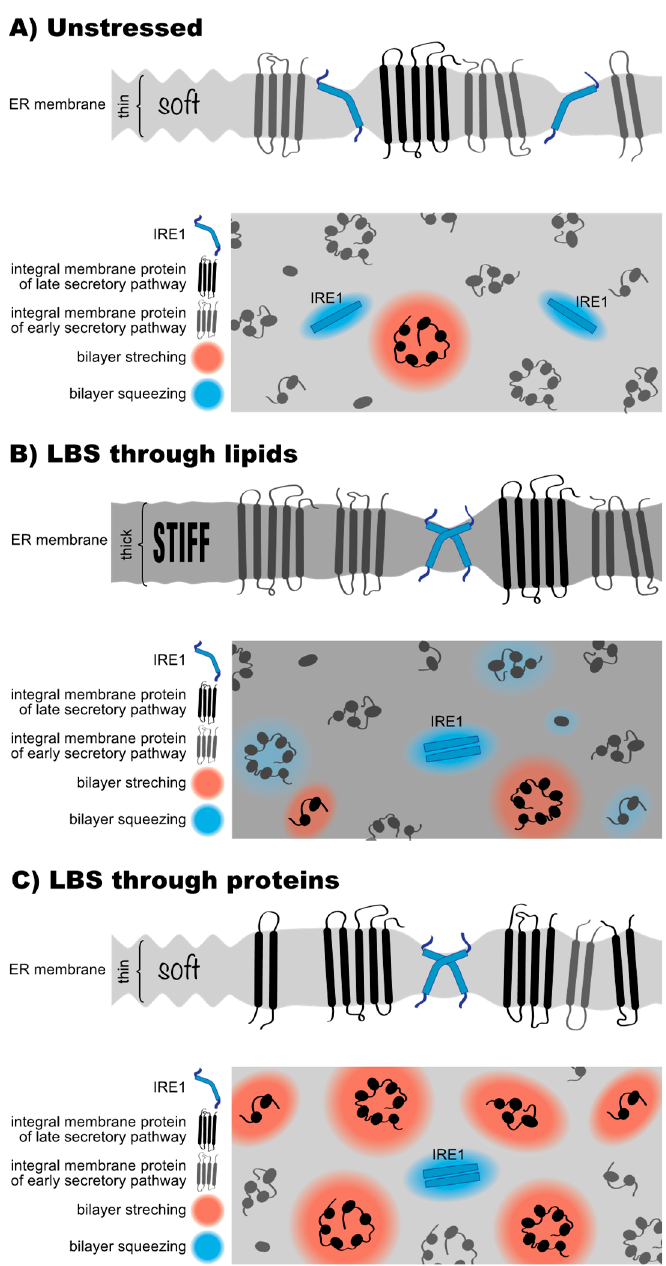
Figure 4. Models for lipid bilayer stress sensing by IRE1. ( A ) The lipid composition of the ER is optimized for accepting all sorts of transmembrane proteins, including plasma membrane proteins (black) with an increased hydrophobic thickness that locally stretches the lipid bilayer to overcome the hydrophobic mismatch (red shade). ScIRE1 (blue) has an unusually short transmembrane helix equipped with ER ‐ luminal amphipathic helix. This unusual transmembrane region causes a local compression of the lipid bilayer to overcome the negative hydrophobic mismatch (blue shade). ( B ) Aberrant lipid compositions of the ER membrane can cause bilayer stiffening, which in turn in ‐ creases the energetic costs for any hydrophobic mismatch. The unusual transmembrane architecture of ScIRE1 renders it particularly sensitive to ER membrane stiffening. The total area of membrane compression around ScIRE1 is minimized by a membrane ‐ driven dimerization/oligomerization, which also activates the UPR. ( C ) Issues with protein folding in the ER or problems in the secretory pathway can cause an accumulation of proteins of the late secretory pathway (black) in the ER. The local stretching of the lipid bilayer (red shade) increases the local membrane stiffness thereby creat ‐ ing ‘no ‐ go ‐ areas’ for ScIRE1. The effective up ‐ concentration of ScIRE1 and an increased membrane stiffness trigger the UPR by forcing ScIRE1 in dimers/oligomers.